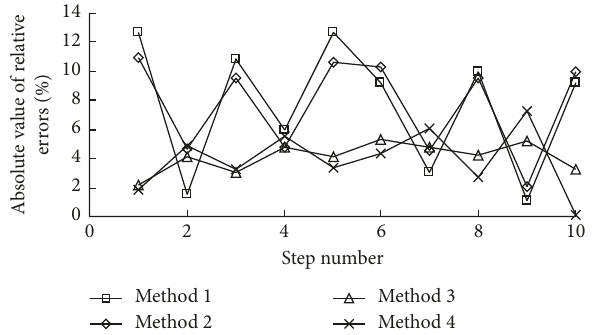
Figure 8: Absolute value of the relative errors from the prediction results from subseries X 3